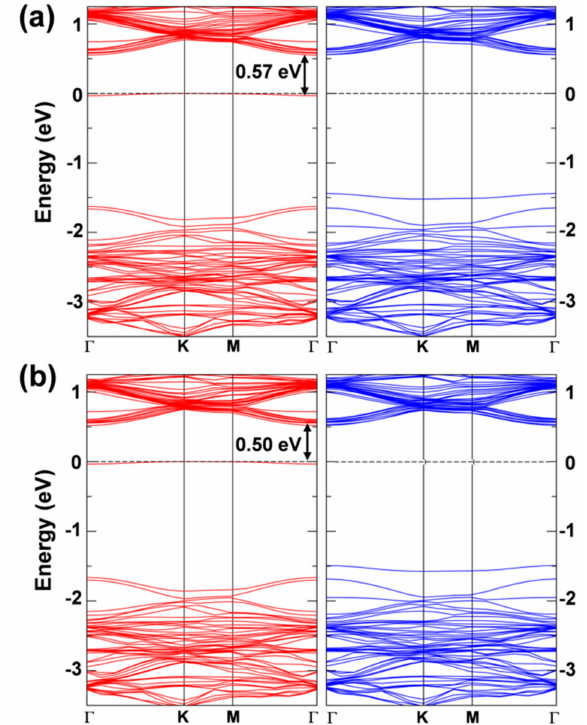
Figure 6. Band structure of the 6 × 6 supercell WSe 2 monolayer with one self-trapped electron obtained by HSE06/CRY14. ( a ) is for the most stable solution (in Figure 5b) and ( b ) is for the less stable solution (in Figure 5c). Red and blue lines represent the spin up (majority) and spin down (minority) bands, respectively. The Fermi level is scaled to zero. One energy difference at Γ is reported in